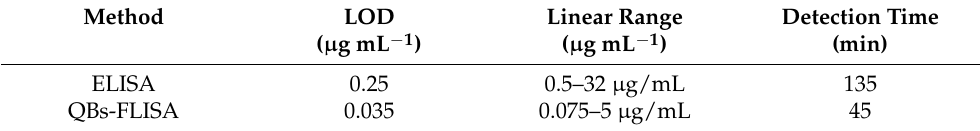
Table 3. Comparison of the developed QBs-FLISA and ELISA.